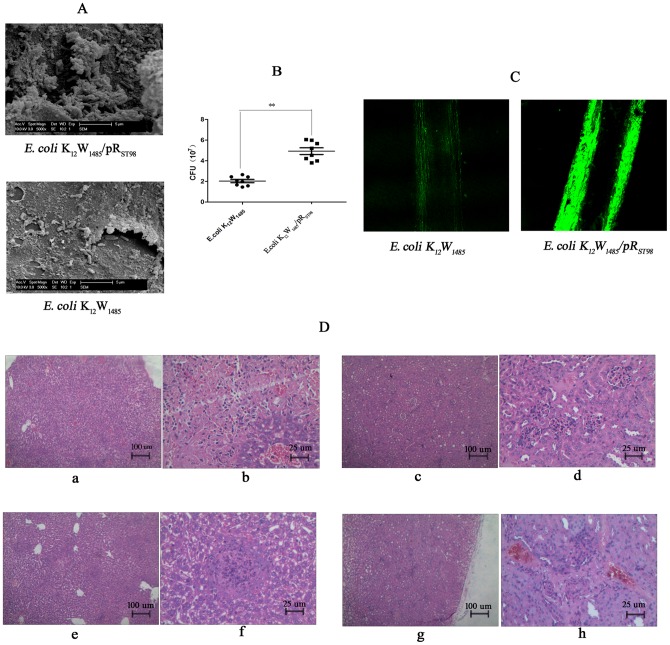
PE10 tubes recovered from the mouse urethral catheter model and histological changes of livers and kidneys.(A) Analysis of K12W1485 and K12W1485/pRST98 BF on PE10 tubes at 5 d p.i. by SEM. (B) Quantification of K12W1485 and K12W1485/pRST98 colonizing on PE10 tubes at 5 d p.i. (p <0.05). Dots and dashes indicate the cfu of K12W1485 and K12W1485/pRST98, respectively, recovered from BF on PE10 tubes. The middle long horizontal line represents the mean cfu, and the short line represents the SD, (**p <0.01). (C) The tubes recovered from mice after urethral catheter at 5 d p.i. were washed with PBS and stained with AO, and bacteria were detected by CLSM. (D) H&E staining of livers and kidneys at 8 d after application of urethral catheter. (a and b), Livers of mice infected with K12W1485. (c and d), Kidneys of mice infected with K12W1485. (e and f), Livers of mice infected with K12W1485/RST98. (g and h), Kidneys of mice infected with K12W1485/pRST98.